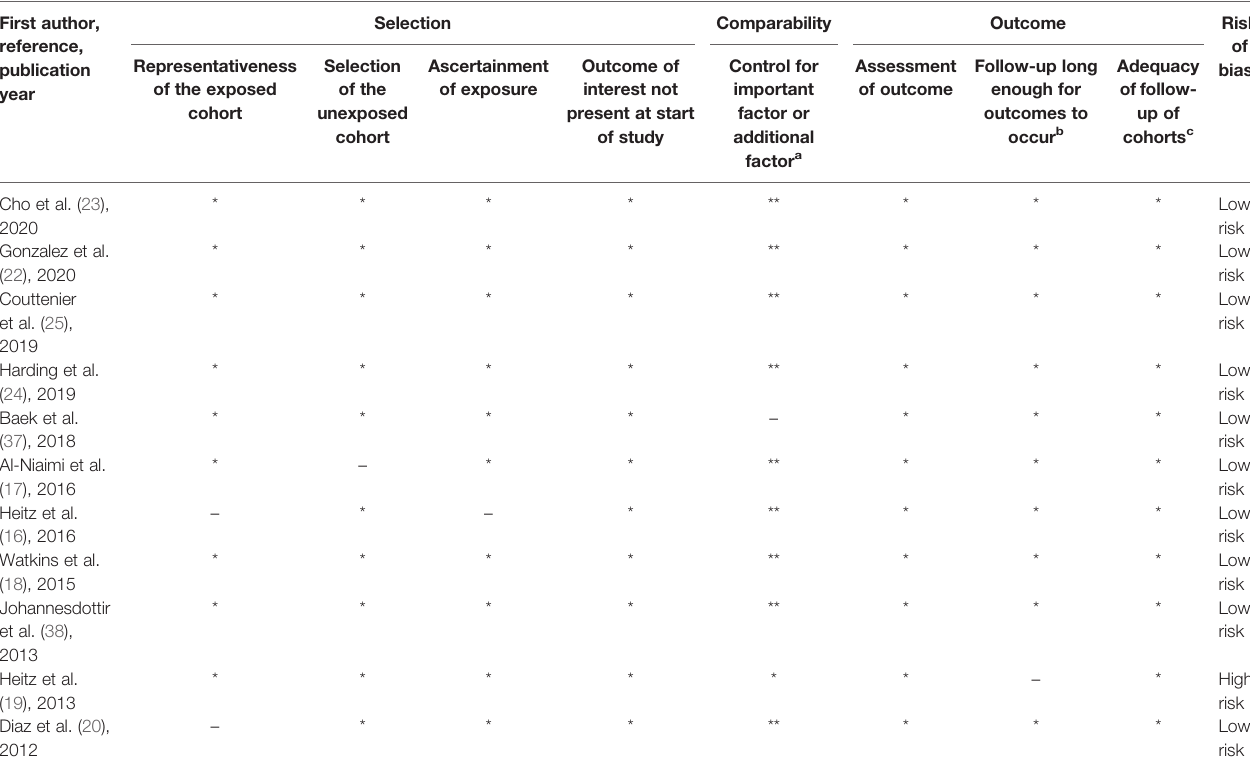
TABLE 3 | Methodological quality of cohort studies included in the